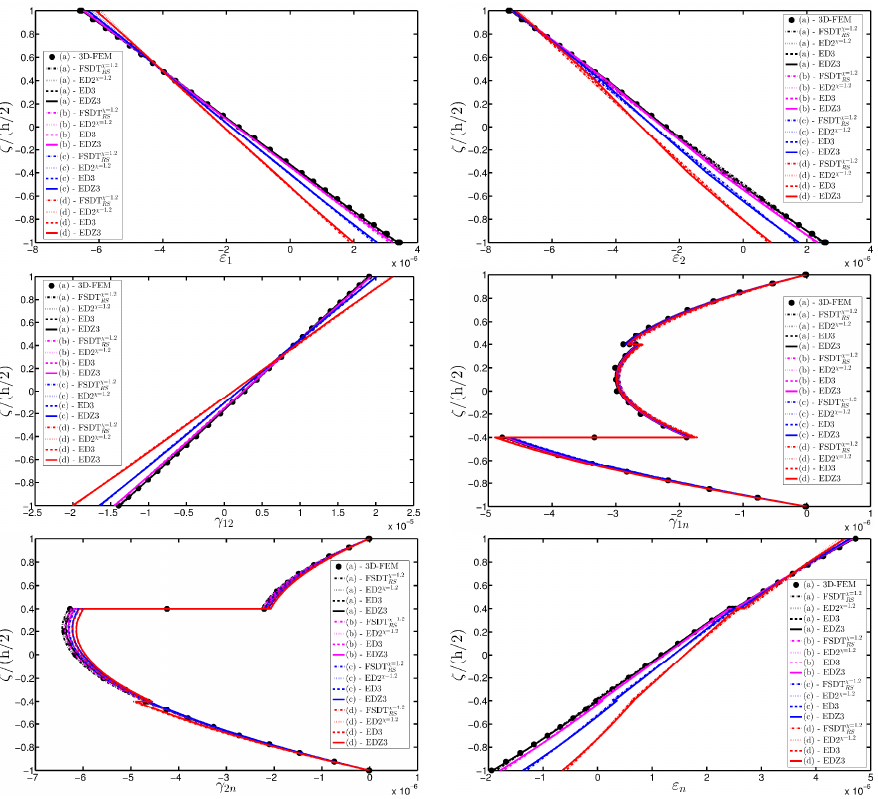
Figure 17. Through-the-thickness profiles of strain components for the CCCC laminated square plate with ( − 45/0/45 ) as stacking sequence computed at the point A for different HSDTs. The effect of the damage is investigated by varying the parameters of the function Gau-5.